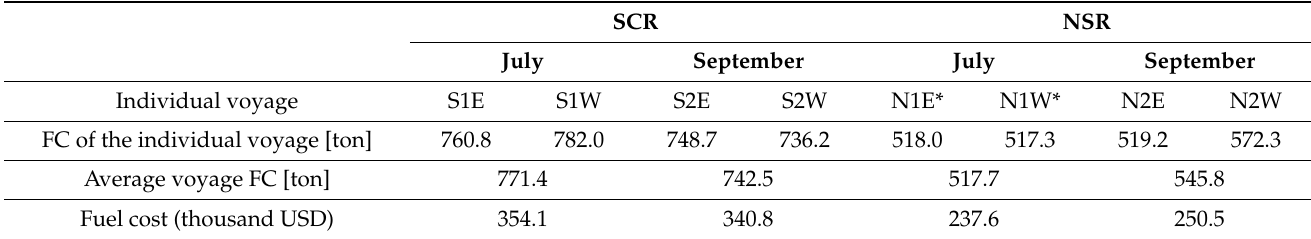
Table 7. Fuel cost per voyage.